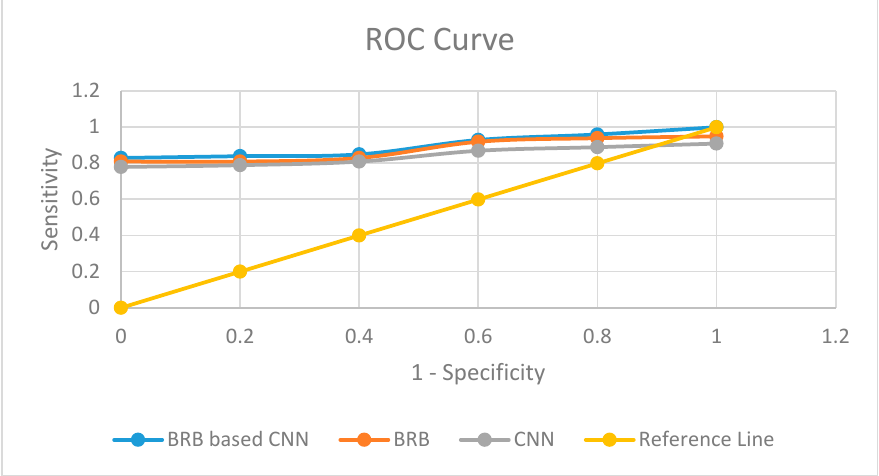
Figure 8. Comparison of results with Receiver Operating Characteristic (ROC) curves.